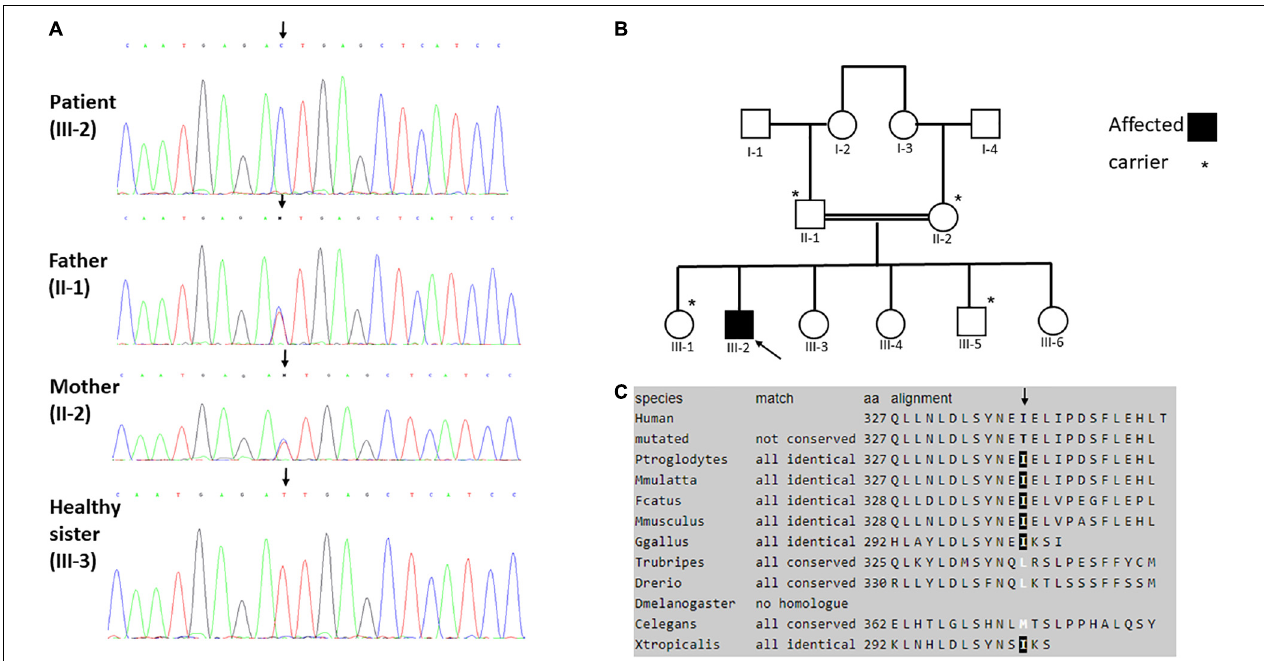
FIGURE 2 | (A) Sanger sequencing showing the LRRC32 homozygous c.980T > C variant in the patient (upper panel), the heterozygous variant in the healthy carrier father and mother (middle panels) and healthy non-carrier sister (lower panel). (B) The family pedigree, illustrating the c.980T > C variant state in all five of the